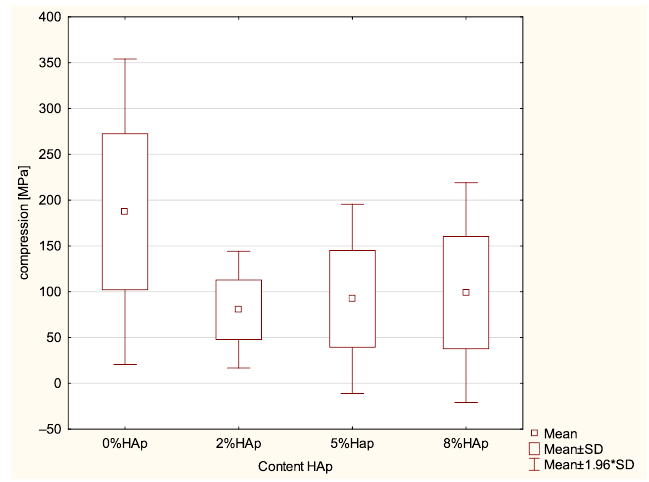
Figure 2. Statistically significant differences in HV among examined groups.